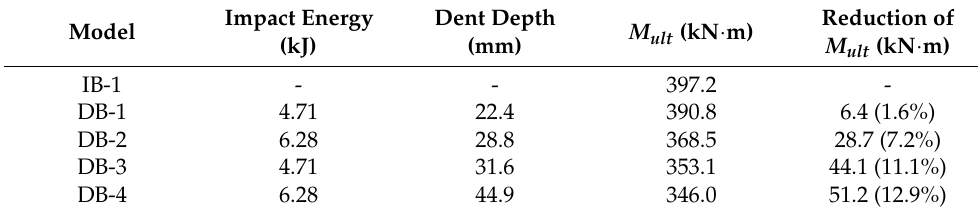
Table 11. The results of the longitudinal-bending tests: denting damage. Model